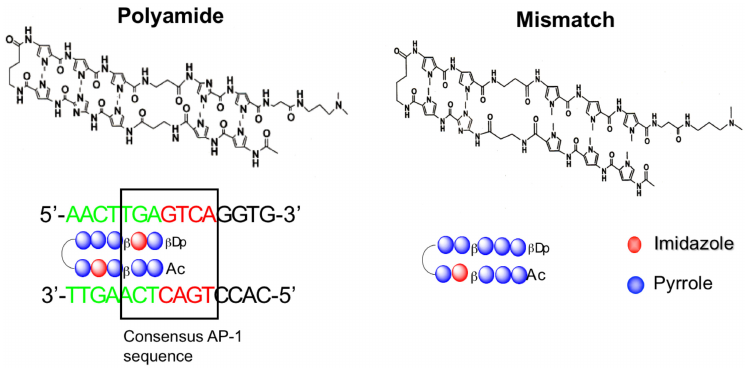
Figure 9. Structure of pyrrole-imidazole (PI) polyamide targeting rat TGF- β 1 and mismatch polyamide (Mismatch). PI polyamide targeting TGF- β 1 was designed to span the boundary of the activator protein-1 (AP-1) binding site (Box: -2303 to -2297) of the TGF- β 1 promoter. Mismatch was designed not to bind transcription binding sites of the promoter. Polyamides were synthesized by solid-phase methods and were purified by HPLC (0.1% AcOH / CH3CN 0 to 50% linear gradient, 0 to 40 min, 254 nm through a Chemcobond 5-ODS-H